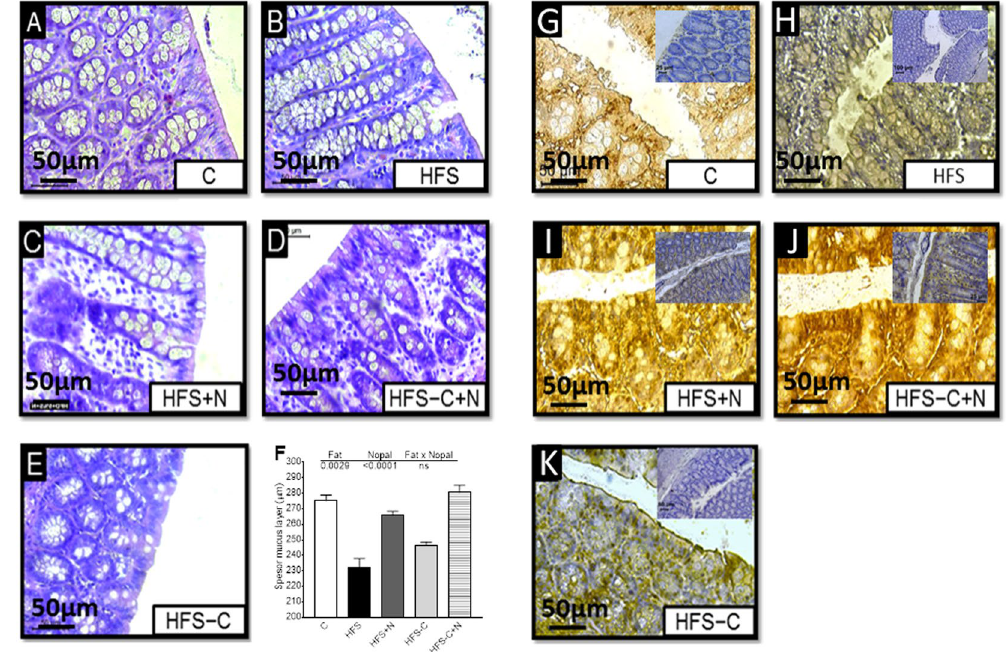
Figure 5. Effect of nopal consumption on histological morphology and expression of occludin-1 in the colon of Wistar rats fed different dietary treatments. ( A – E ) Hematoxilin-Eosin staining (HE), ( F ) Mucosal layer quantitative analysis. Values are shown as means ± SEM, n = 5 rats per group and ( G – K ). Immunohistochemical analysis of occludin-1 in the colon of rats fed control diet ( C ), high fat diet with 5% sucrose in their drinking water (HFS), obese rats consuming HFS + 5% nopal (HFS + N), and obese rats switched to C diet with (HFS-C + N) or without (HFS-C) 5% nopal at the end of the treatment period 400X